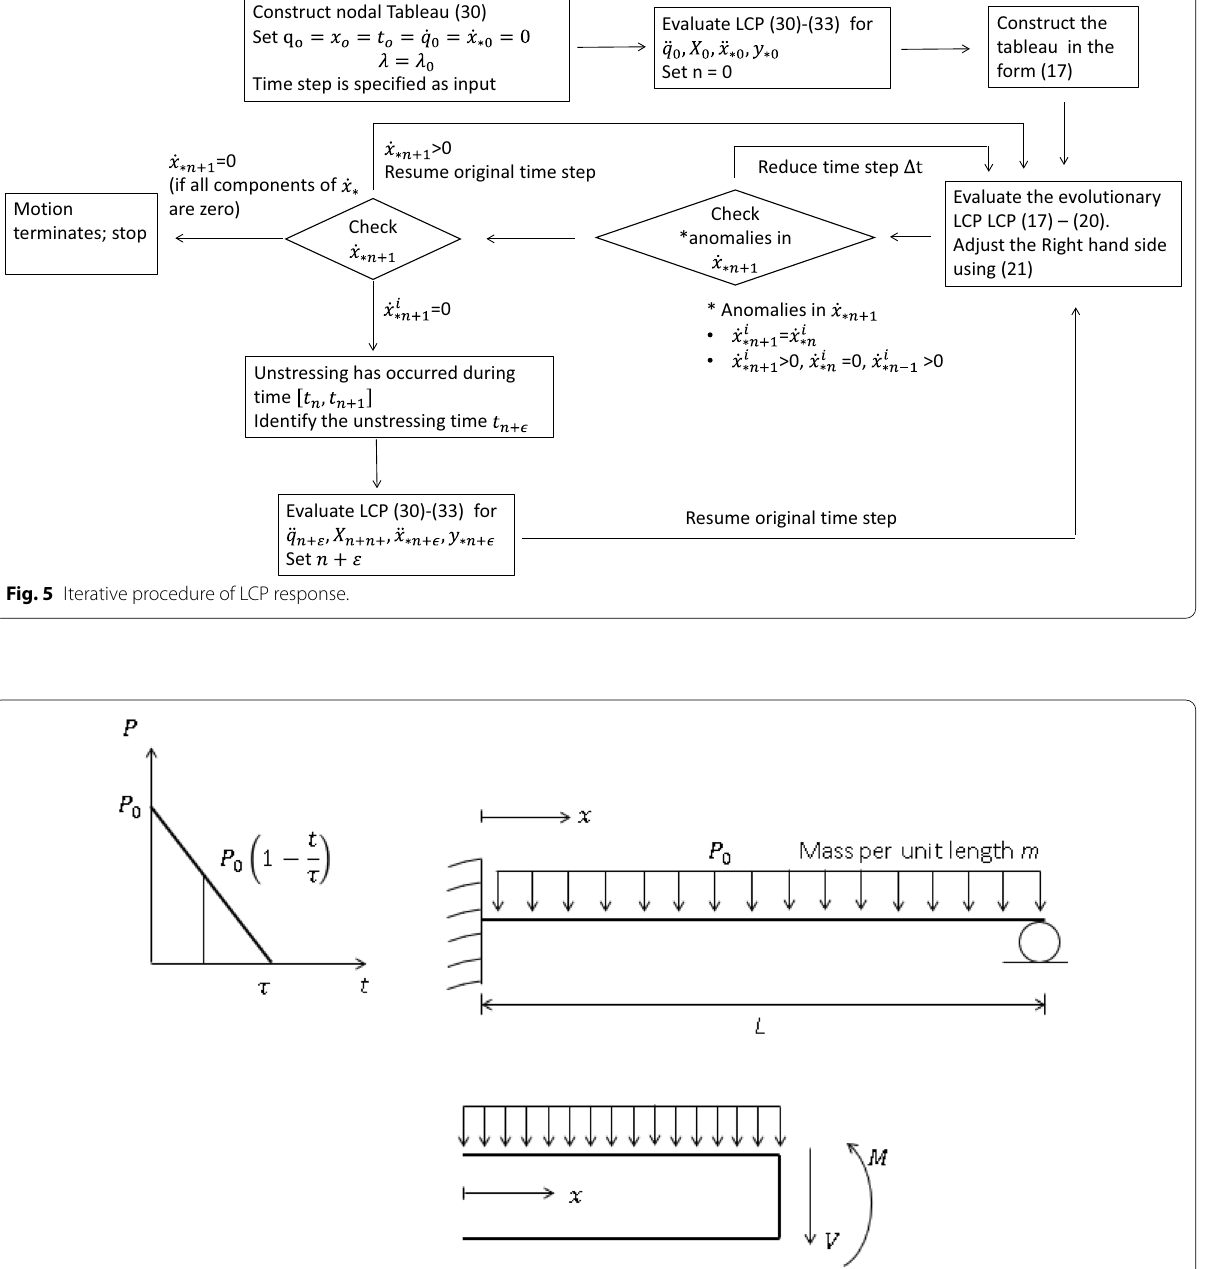
Fig. 6 Propped cantilever beam subjected to triangular pulse